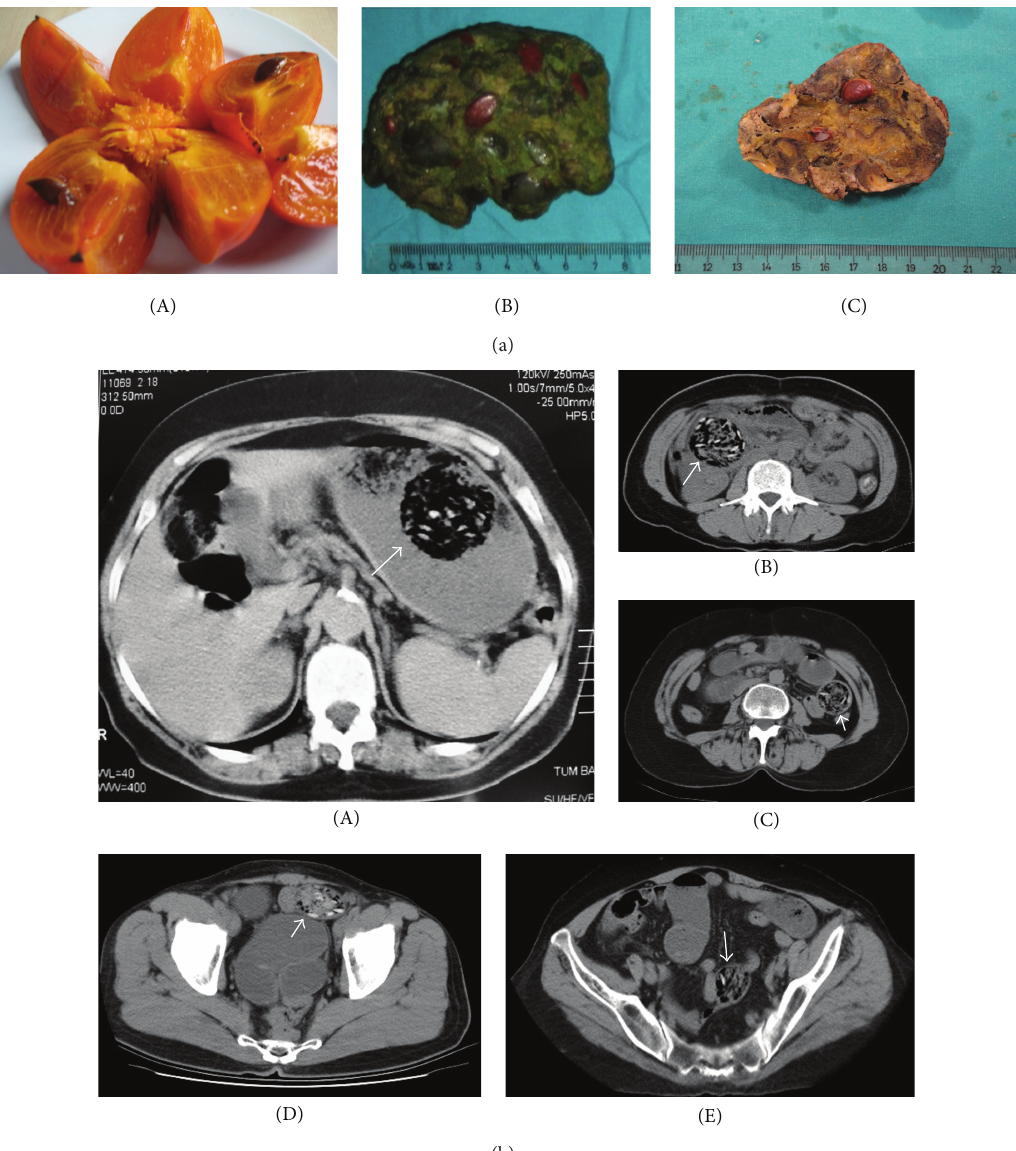
Figure 4: (a) Macroscopic appearance: (A) a seedy type of persimmon, (B)-(C) bezoars caused by a seedy type of persimmon. The bezoar seemed to contain a large number of seeds, and large air slits were seen. (b) CT findings of bezoars due to seedy type persimmon. Bezoar views which have different shapes and sizes and large amount of air and contained hyperdense ovoid seeds that had settled in different locations at different levels of the gastrointestinal system (arrows). (A) Stomach, (B)-(C) jejunum, and (D)-(E)